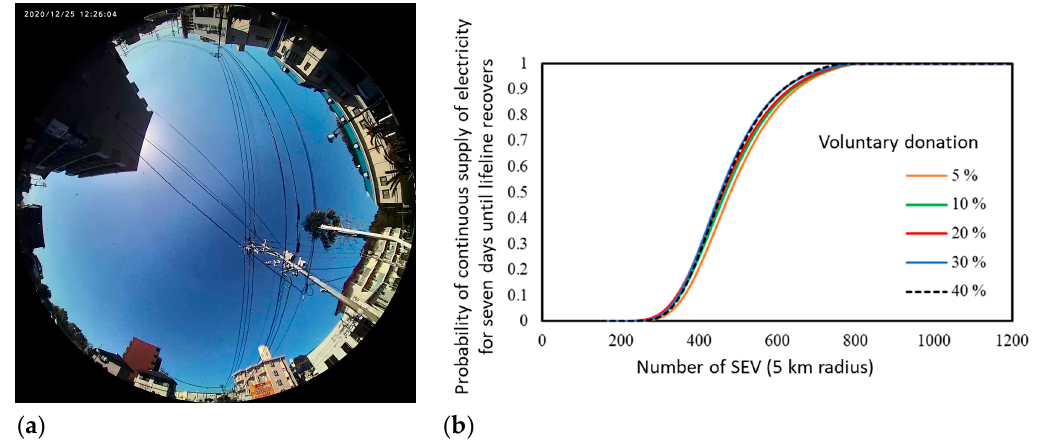
Figure 17. Probability of sustaining resilience energy for a week in residential zone: ( a ) fisheye image; ( b ) probability curves.